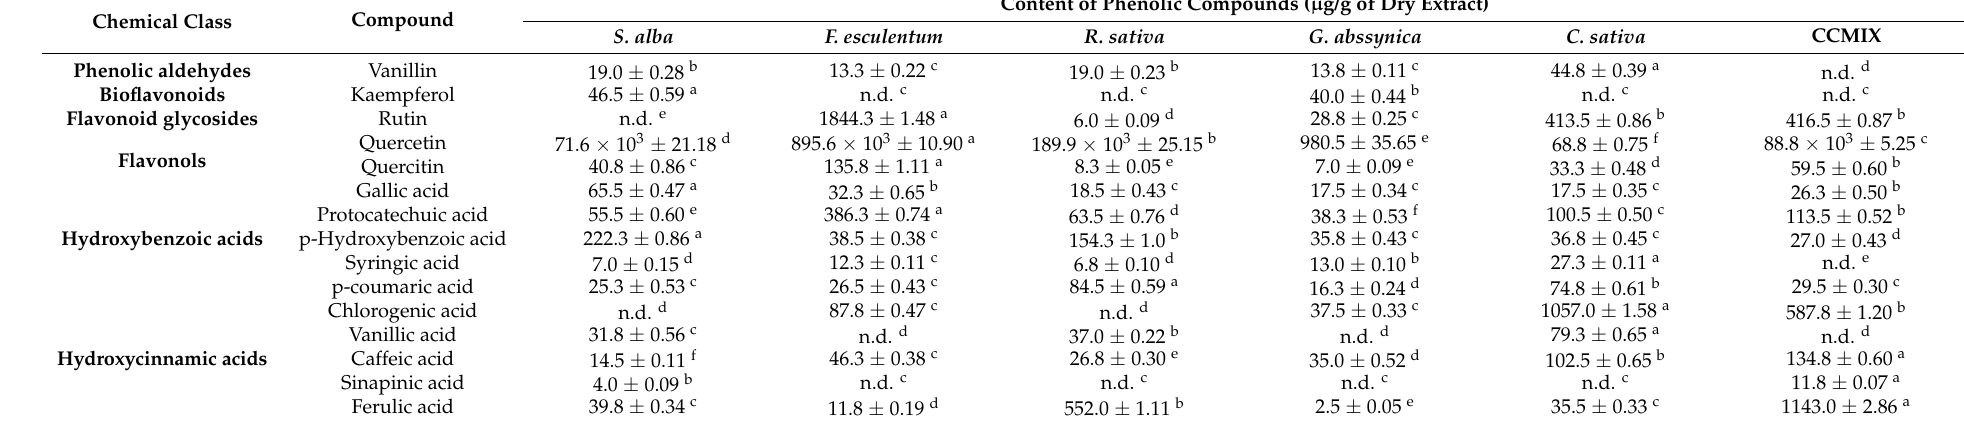
Table 5. Quantification of phenolics in aqueous extracts from six cover